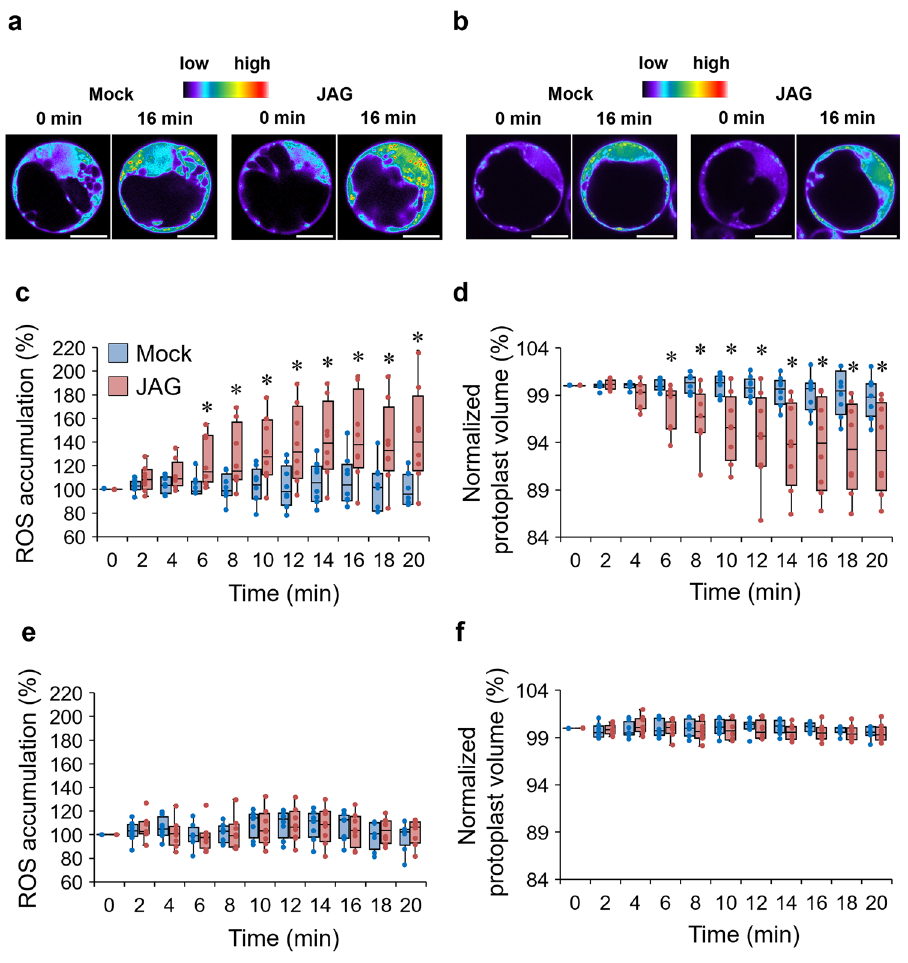
Figure 3. JAG-induced ROS accumulation is involved in leaf-close movement in Samanea saman . ( a , b ) Representative images of reactive oxygen species (ROS) accumulation in ( a ) extensor or ( b ) flexor indicated by fluorescent dye DCF. Motor cell protoplasts of S. saman were loaded with H 2 DCFDA for 45 min before adding 100 µM 12-hydroxyjasmonic acid glucoside (JAG). Photomicrographs were taken using a confocal laser scanning microscope at 0 and 16 min after above treatments. Bar = 10 µm. ( c , d ) Box plots represent time course of JAG-induced ( c ) cytosolic ROS accumulation and ( d ) cell shrinkage in tertiary extensor protoplasts of S. saman following above treatment as in (a). All data points are shown as dot plots (n = 8). ( e , f ) Box plots represent time course of JAG-induced ( e ) cytosolic ROS accumulation and ( f ) cell shrinkage in tertiary flexor protoplasts of S. saman following above treatment as in ( b ). All data points are shown as dot plots (n = 8). Asterisks indicate significant differences (* p < 0.05; t -test) in ( c )–( f ). All experiments were conducted during ZT 6–11. Four independent experiments were